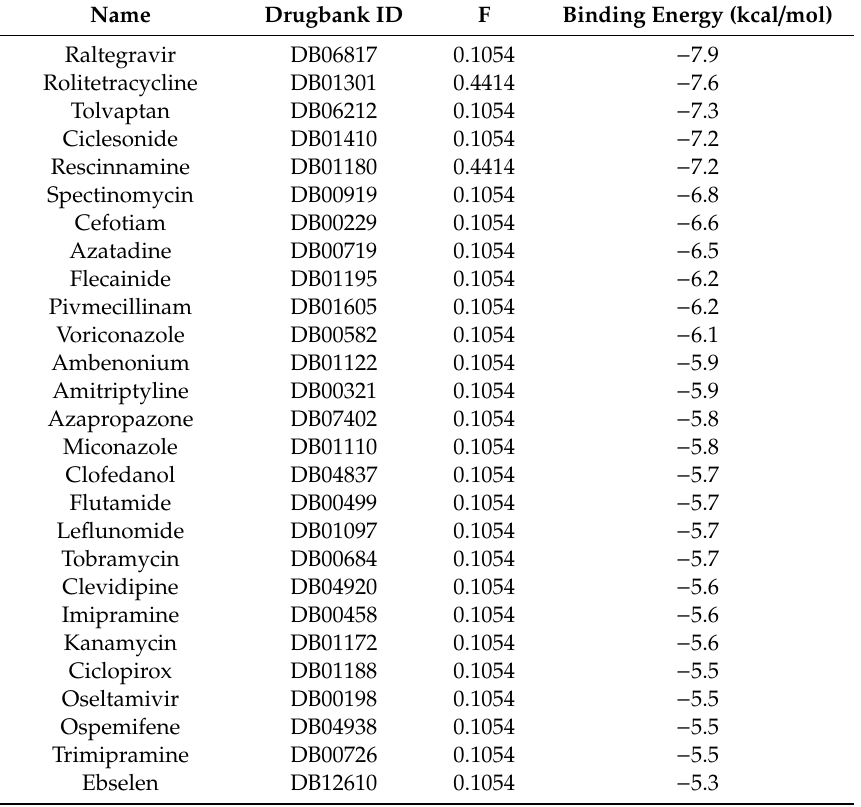
Table 2. Docking scores of the compounds binding to the allosteric